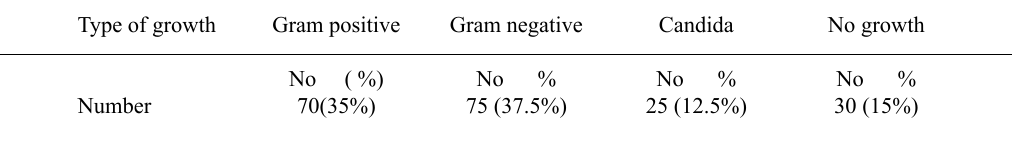
table 3. Identification of 50 staphylococci